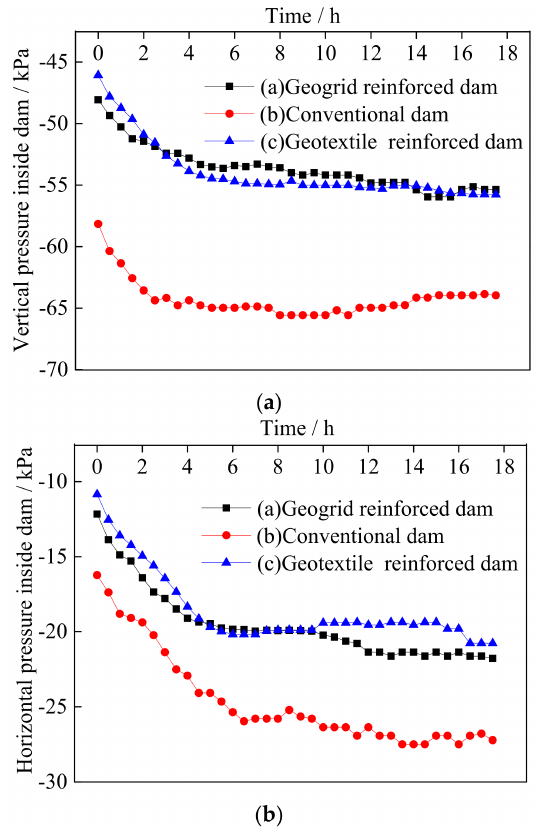
Figure 11. Comparison of IP over time in the three tailings dams: ( a ) vertical direction; ( b ) horizon- tal